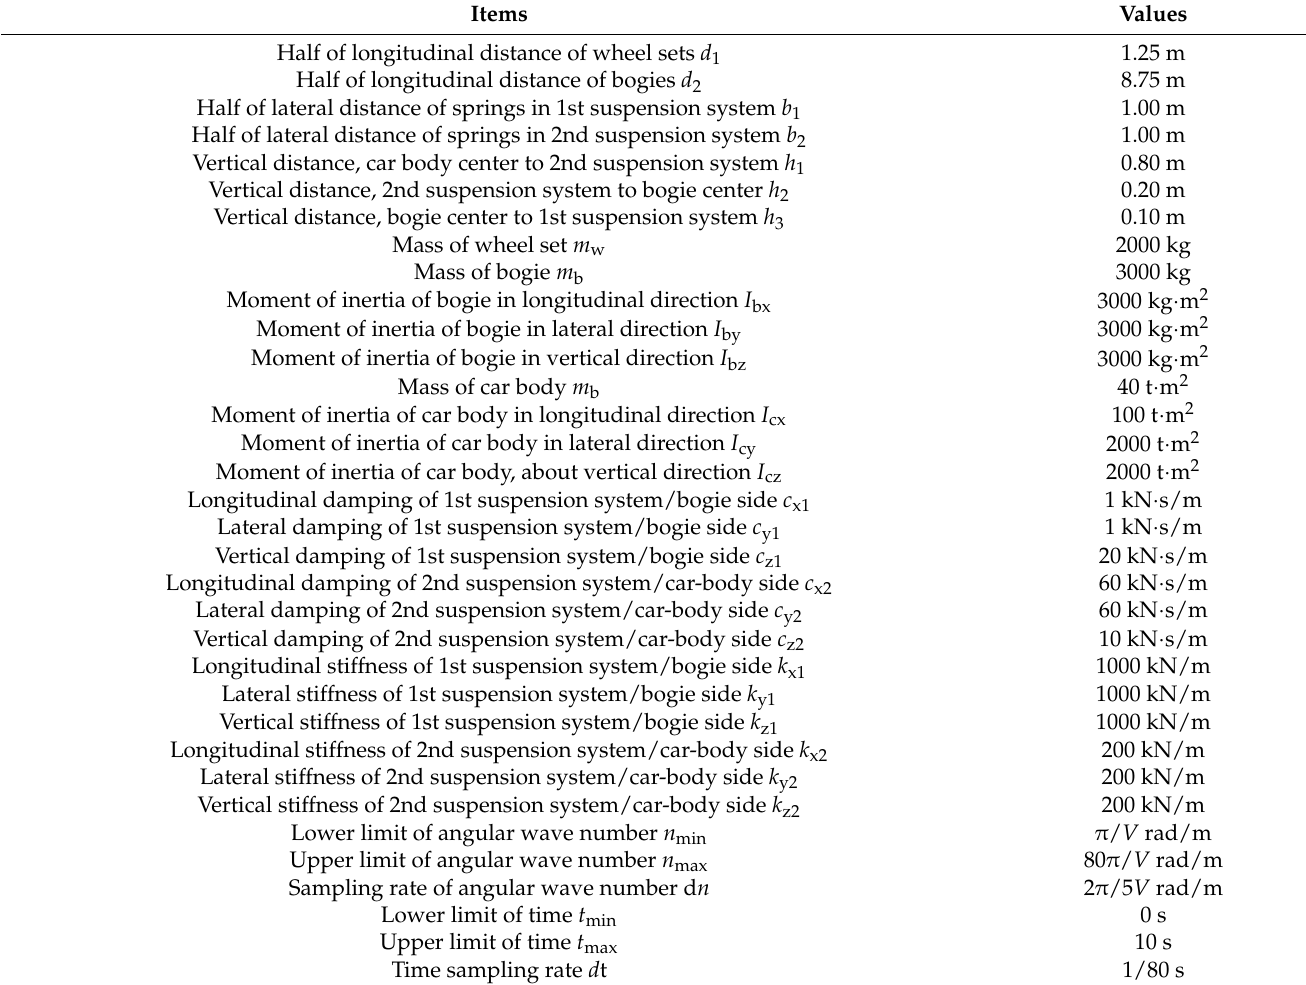
Table 3. Parameters of the train